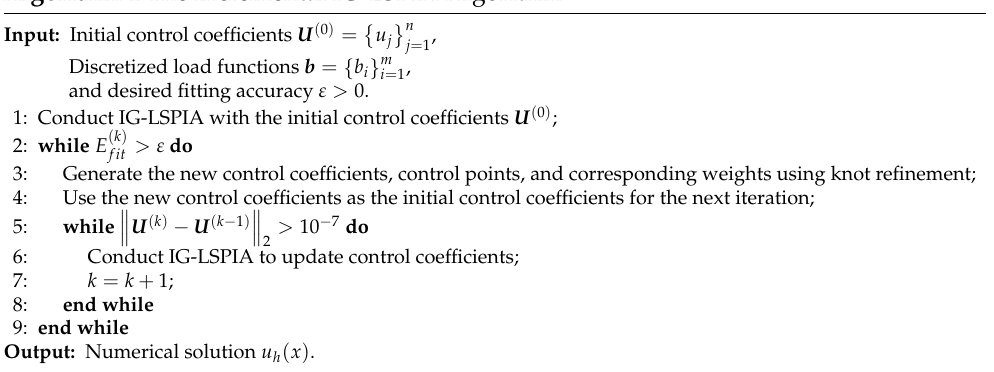
Algorithm 1 The Incremental IG-LSPIA